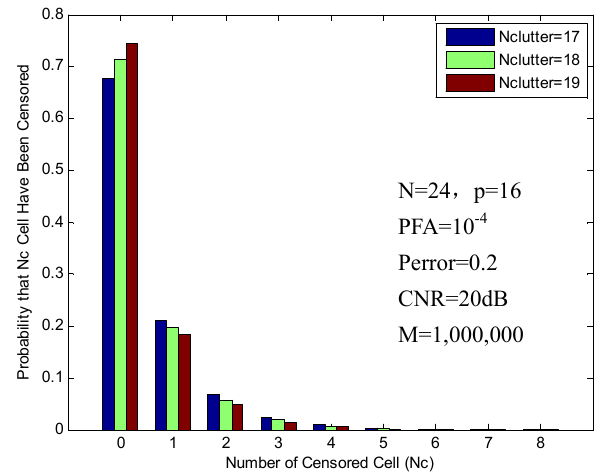
Figure 11. Probability of censoring in the clutter edge environment (17, 18 and 19 clutter cells).